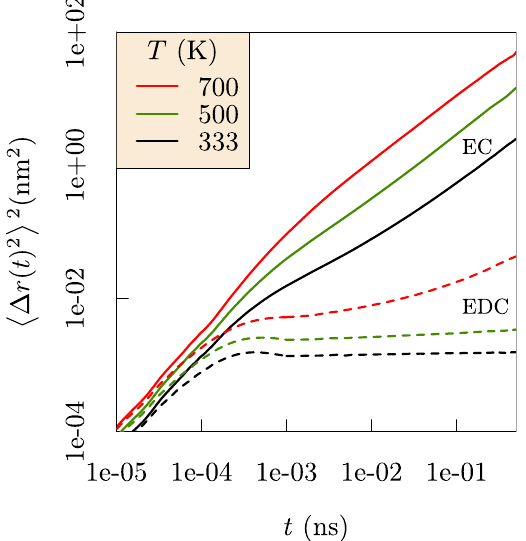
Figure 6. Comparison between mean-squared displacements of carbonyl carbon of EDC and EC. The flat MSD at larger time-scales reflects the glassy nature of the EDC matrix.